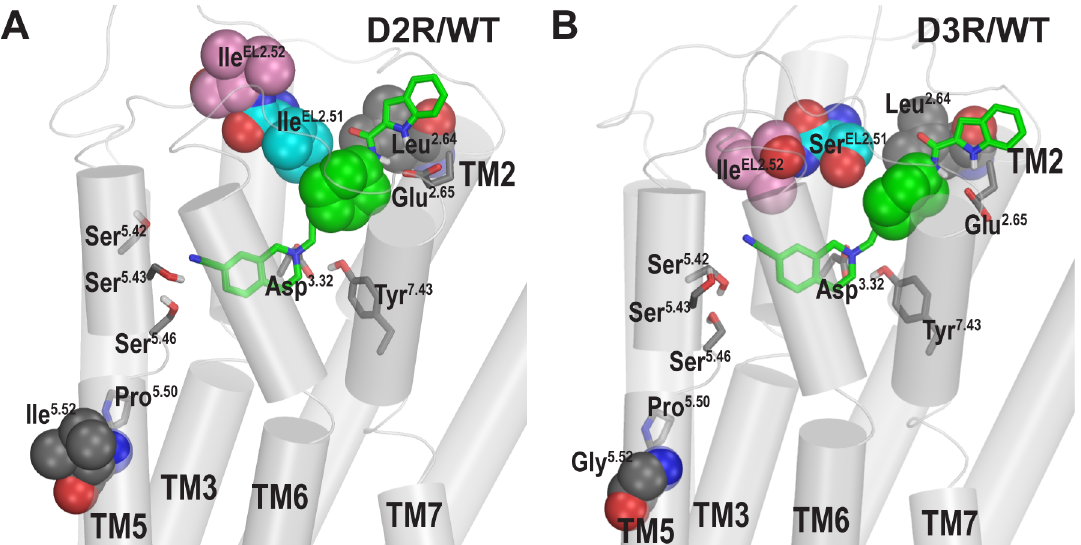
Fig 3. Divergent interactions of SB269652 with EL2 and TM5 in D2R and D3R. Ile EL2.51 in D2R forms direct hydrophobic interactions with the cyclohexyl linker of SB269652 and Leu 2.64 ( A ), while the aligned Ser EL2.51 in D3R cannot ( B ), resulting in different orientations of Ile EL2.52 in these two receptors. In addition, the divergence in EL2 and near the proline-kink of TM5 (position 5.52) contributes to the different interactions of the serines on top of TM5 with the cyano group of SB269652 (see text). Molecular graphics was generated using PyMOL Molecular Graphics System (version 1.7.6.5, Schro¨dinger,